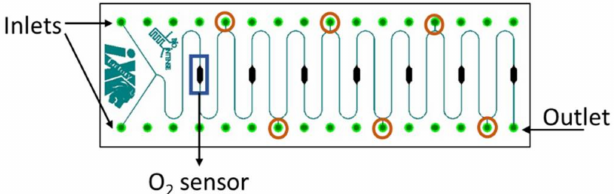
Figure 3. Schematics of the meander microfluidic channel with the main inlets and outlet emphasized. In orange, the five side inlets are highlighted, and in blue one of the seven oxygen sensors is